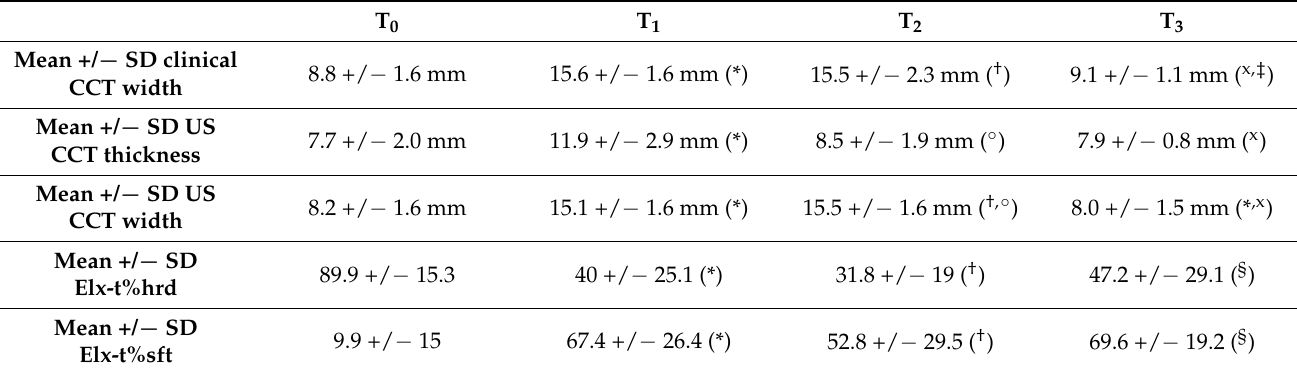
for Elx-t%hrd parameter. The Elx-t%sft parameter was significantly lower in normal CCT (T 0 ) when compared to T 1 , T 2 and T 3 (Figure 5). Table 1. Mean +/ − SD of clinical, ultrasonographic and elastosonographic tendon assessment, at each time point.